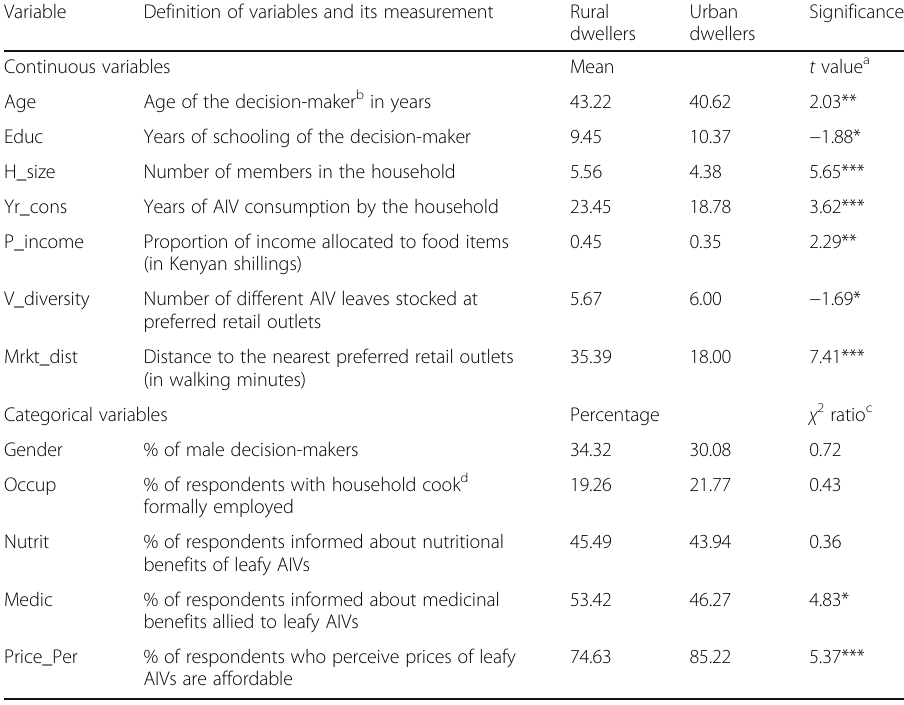
Table 1 Definition of variables used in econometric analysis and descriptive statistics Variable Definition of variables and its measurement Rural